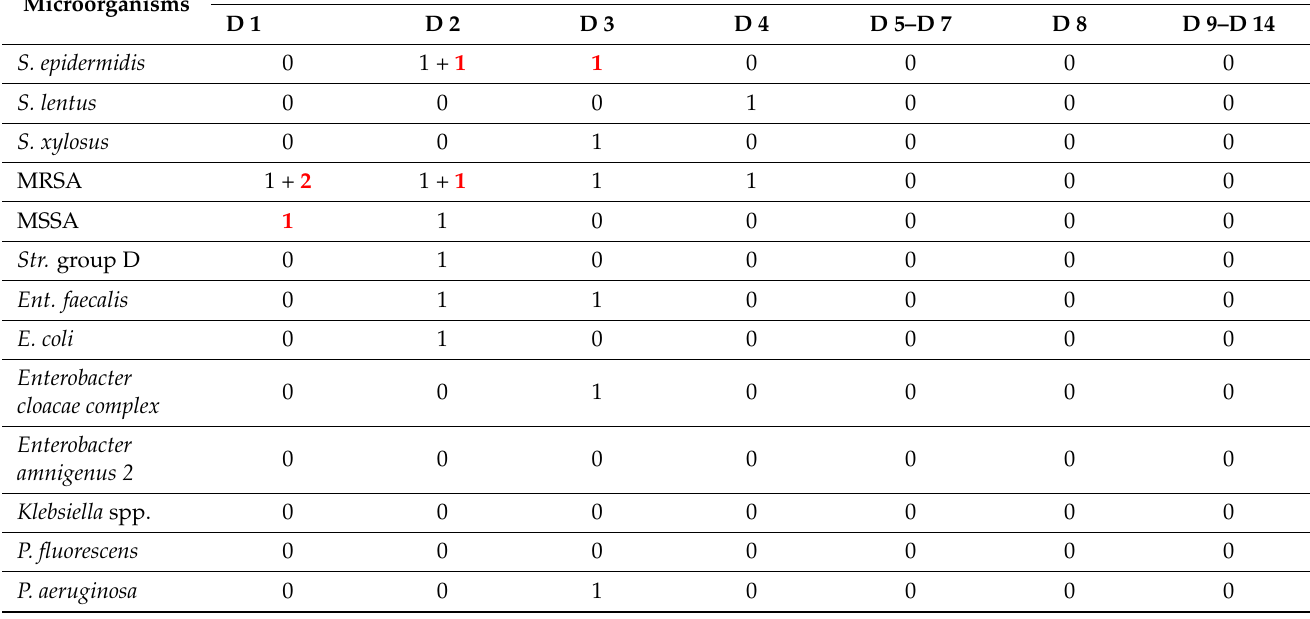
Table 2. Isolated bacterial species (no. of strains identified) from periprosthetic tissue/incubation period